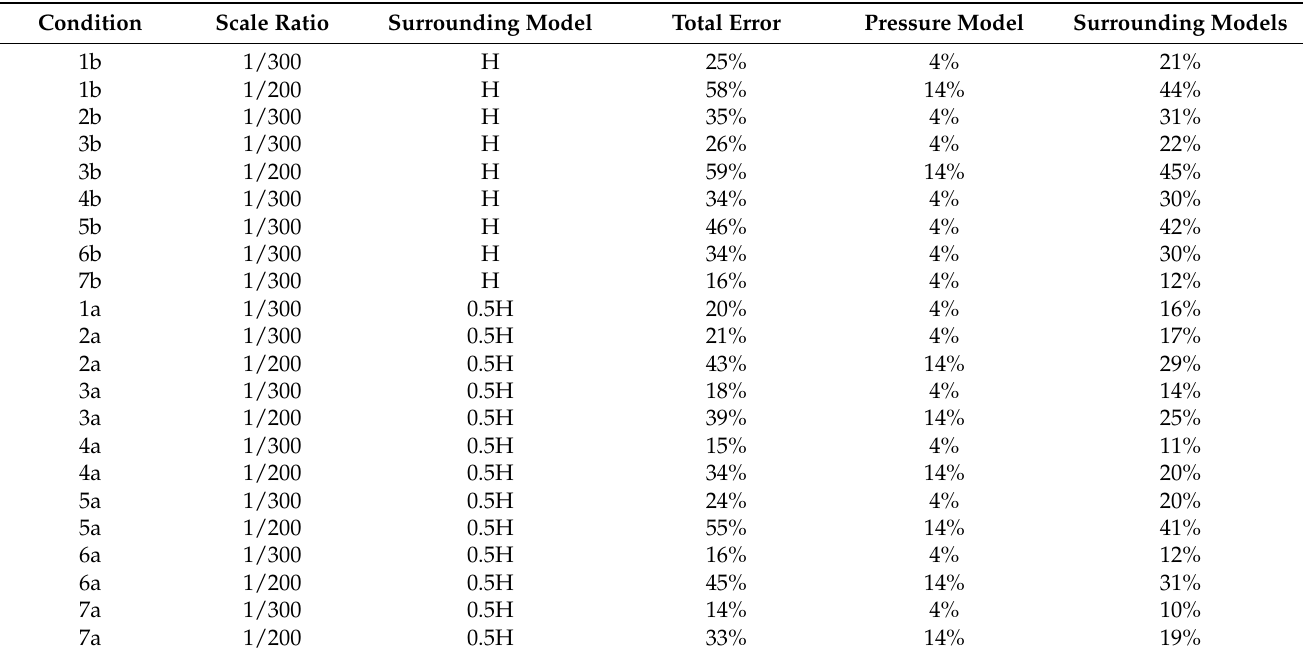
Table 7. The error of the drag coefficient caused by the pressure model and surrounding model.